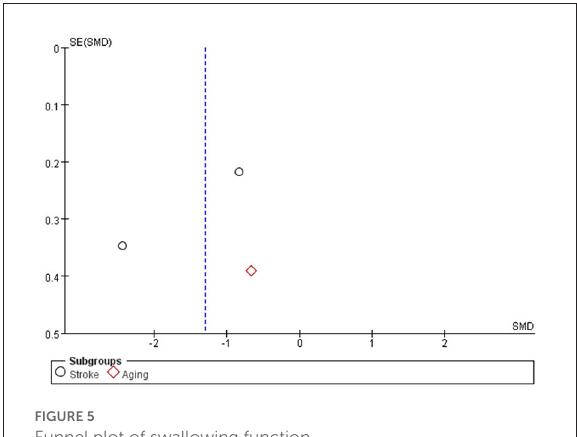
FIGURE5 Funnel plot of swallowing